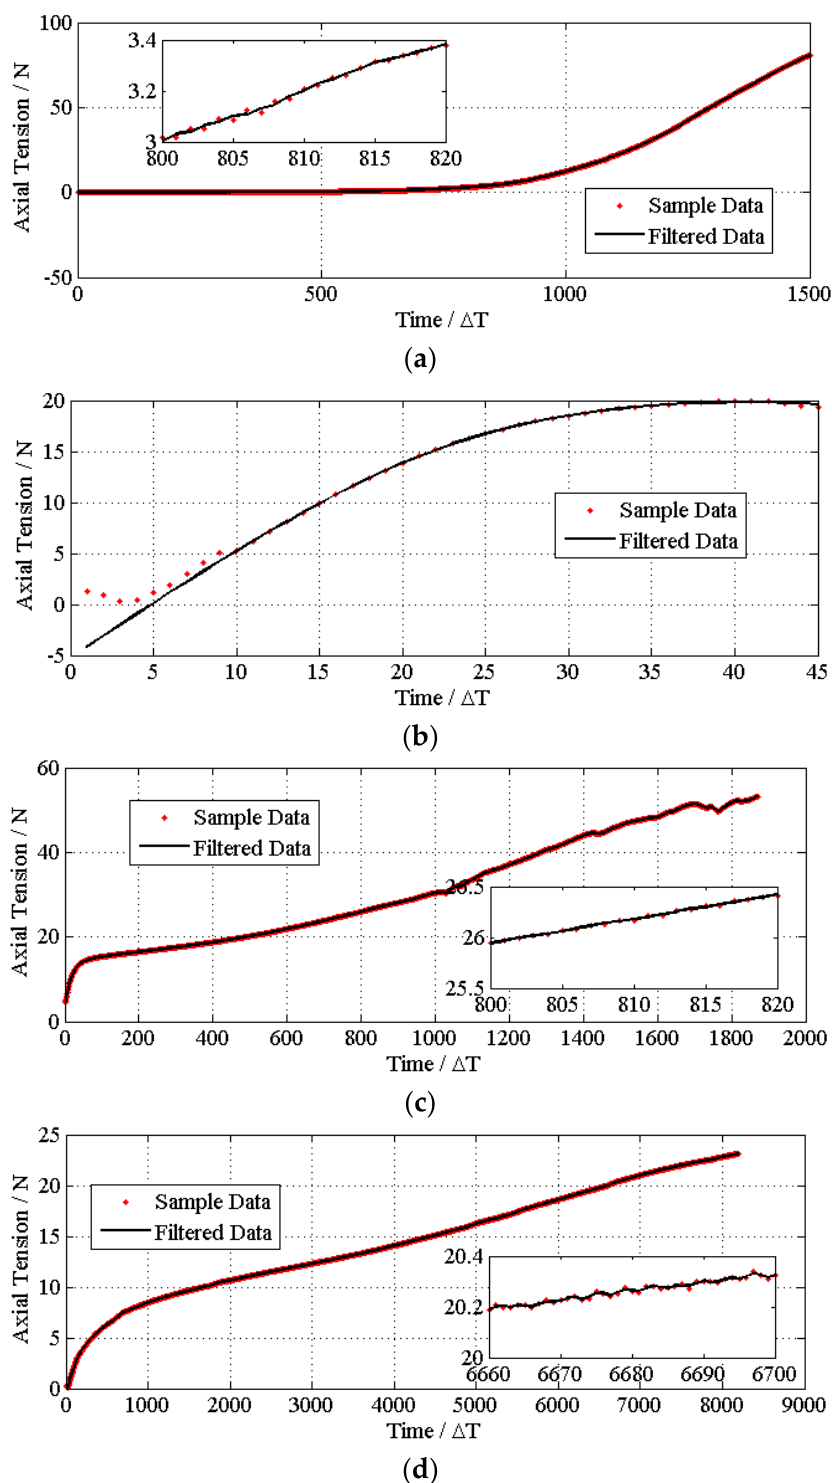
Figure 5. Data filter for each test. The samples data and filtered curves of the tensile strength are